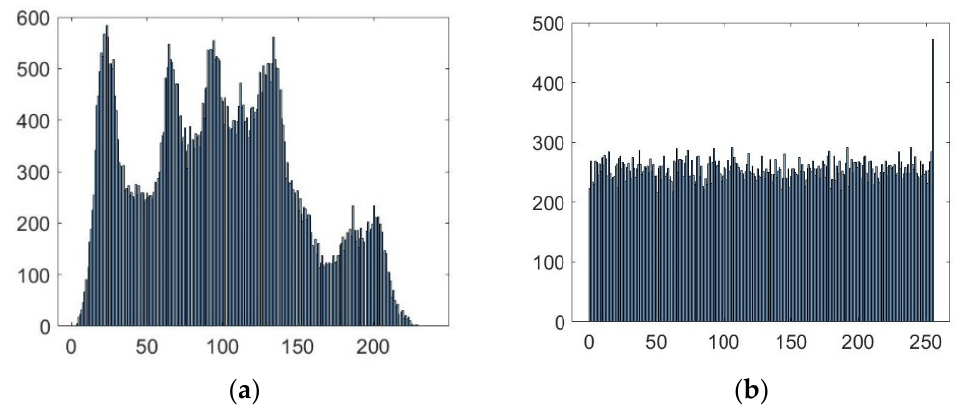
Figure 8. The Lena grayscale image histogram: ( a ) plain image; ( b ) encrypted image.